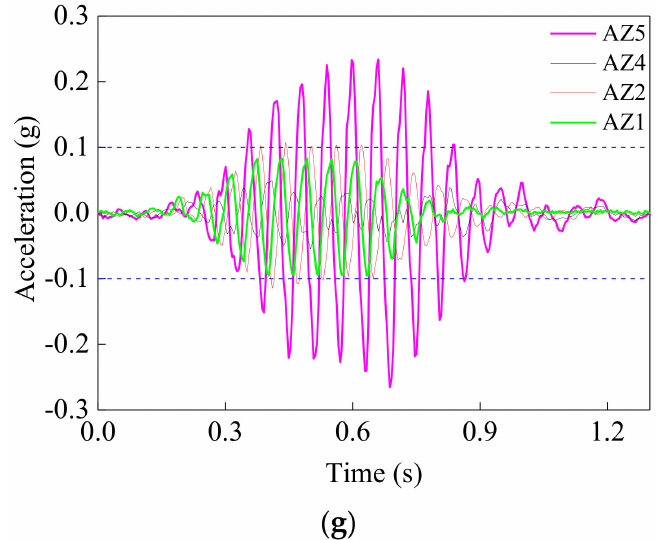
Figure 17. Acceleration responses with depths in ST model. ( a ) Sin-2 ( b ) Sin-3. ( c ) Sin-6 ( d ) Sin-9. ( e ) Sin-11 ( f ) Sin-14. ( g ) Sin-17.